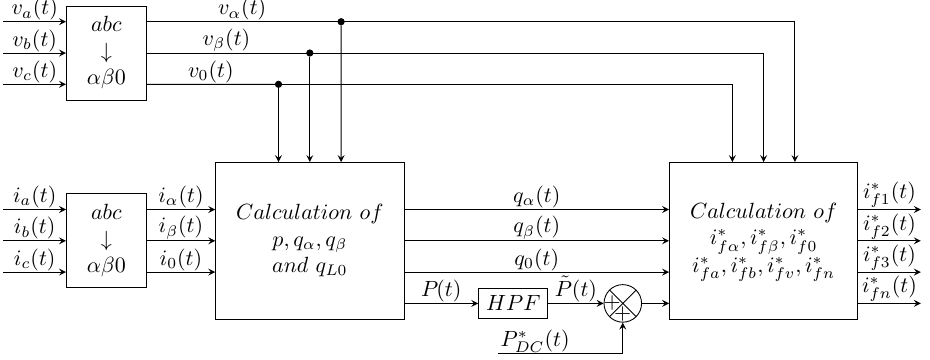
Figure 3. Diagram of Cross-Vector